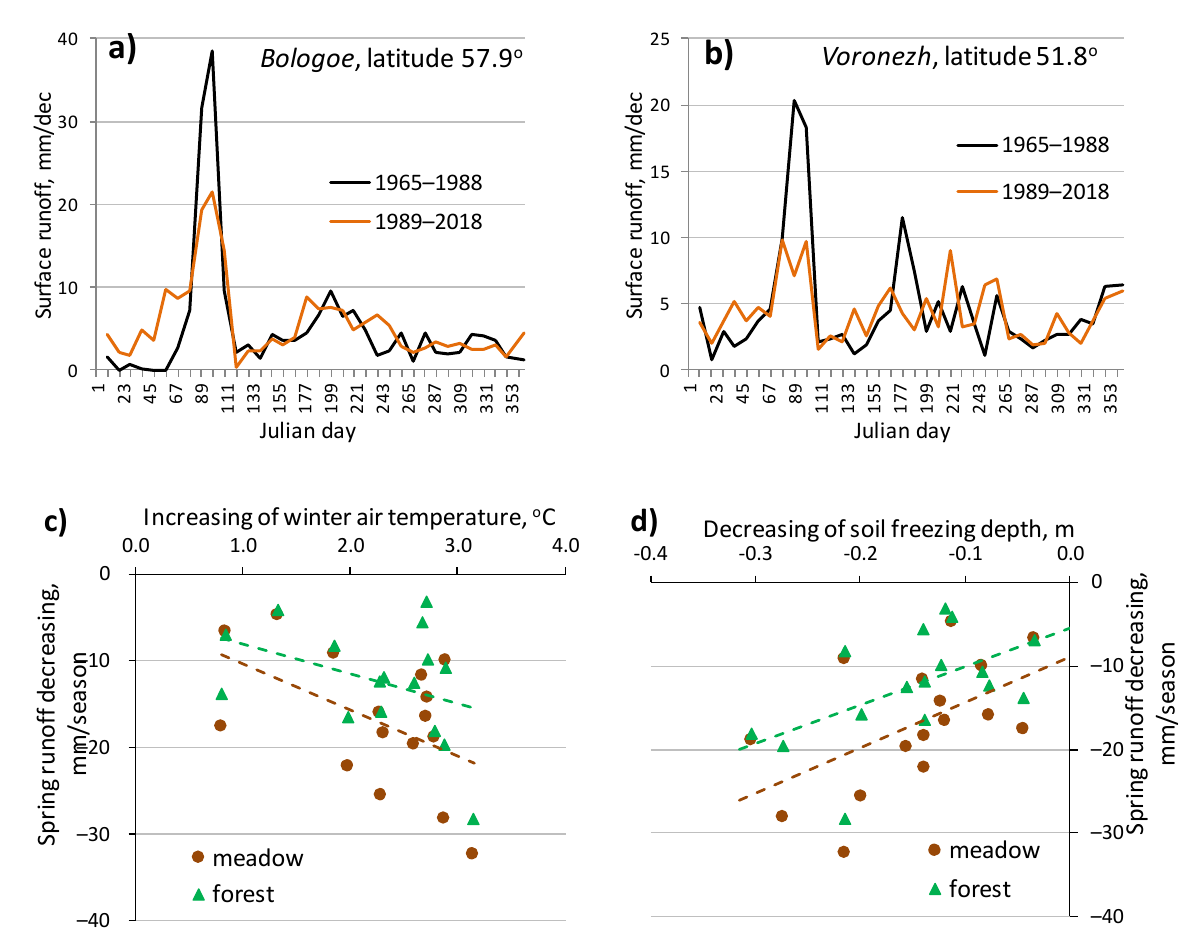
Figure 9. The comparison of simulated intra-annual surface runoff for historical and modern periods in the north ( a ) and in the south ( b ) of ER and correlation between simulated spring surface runoff decreasing on loamy soil and observed increasing of winter air temperature ( c ) and decreasing of soil freezing depth ( d ).